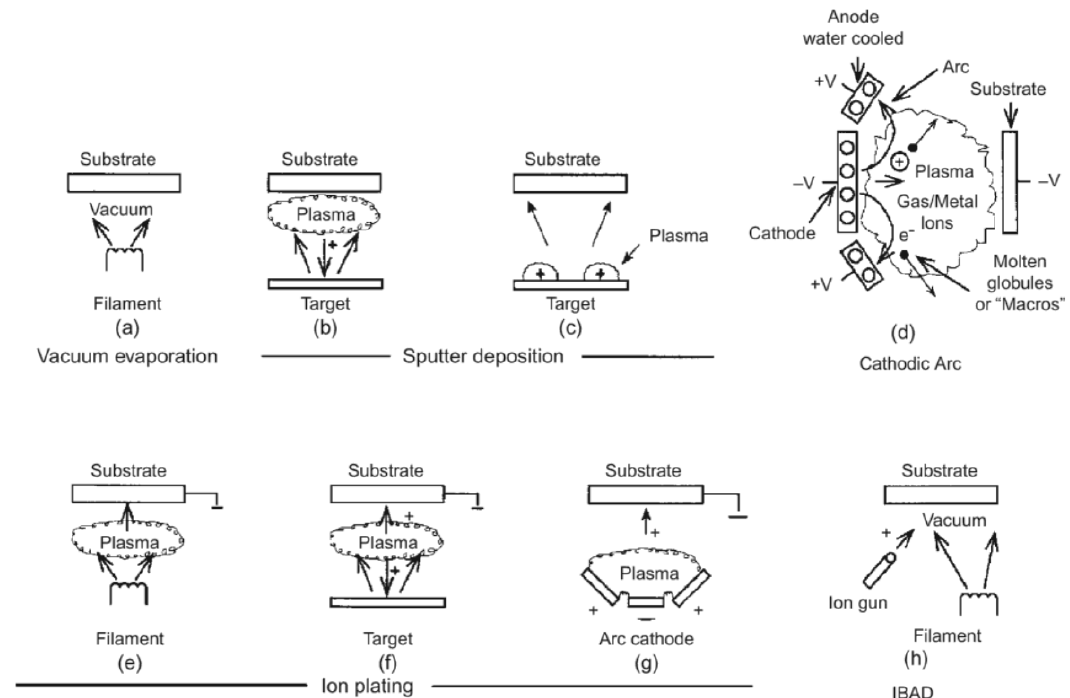
Figure 2. PVD Processing Techniques including categories of vacuum evaporation (a), sputter deposition in a plasma environment (b,c) and in a vacuum (d), ion planting in a plasma environment with a thermal evaporation source (e), with a sputtering source (f) and with an arc vaporization source and ion-assisted deposition (IBAD) ( h ) (g) and ion-assisted deposition (IBAD) (h) [35].